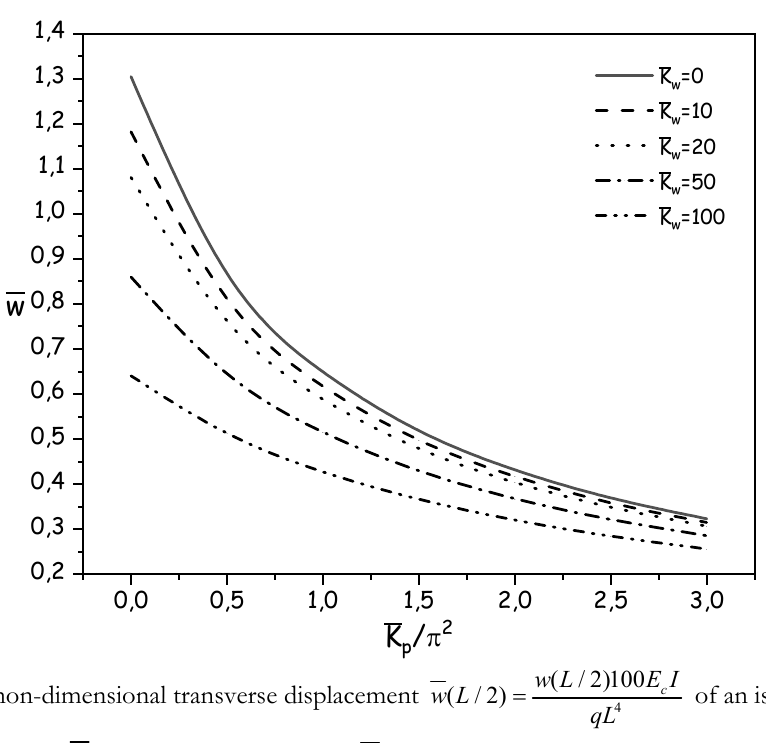
Figure 2: Variation of the non-dimensional transverse displacement